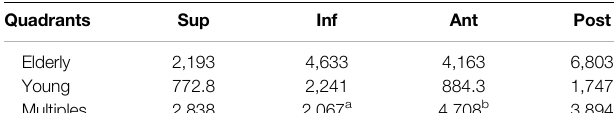
TABLE 7 | The minimum principal strain and mean SED of cortical bone in the elderly and the young. Absolute values of the minimum principal strain at tissue scale ( μ ε